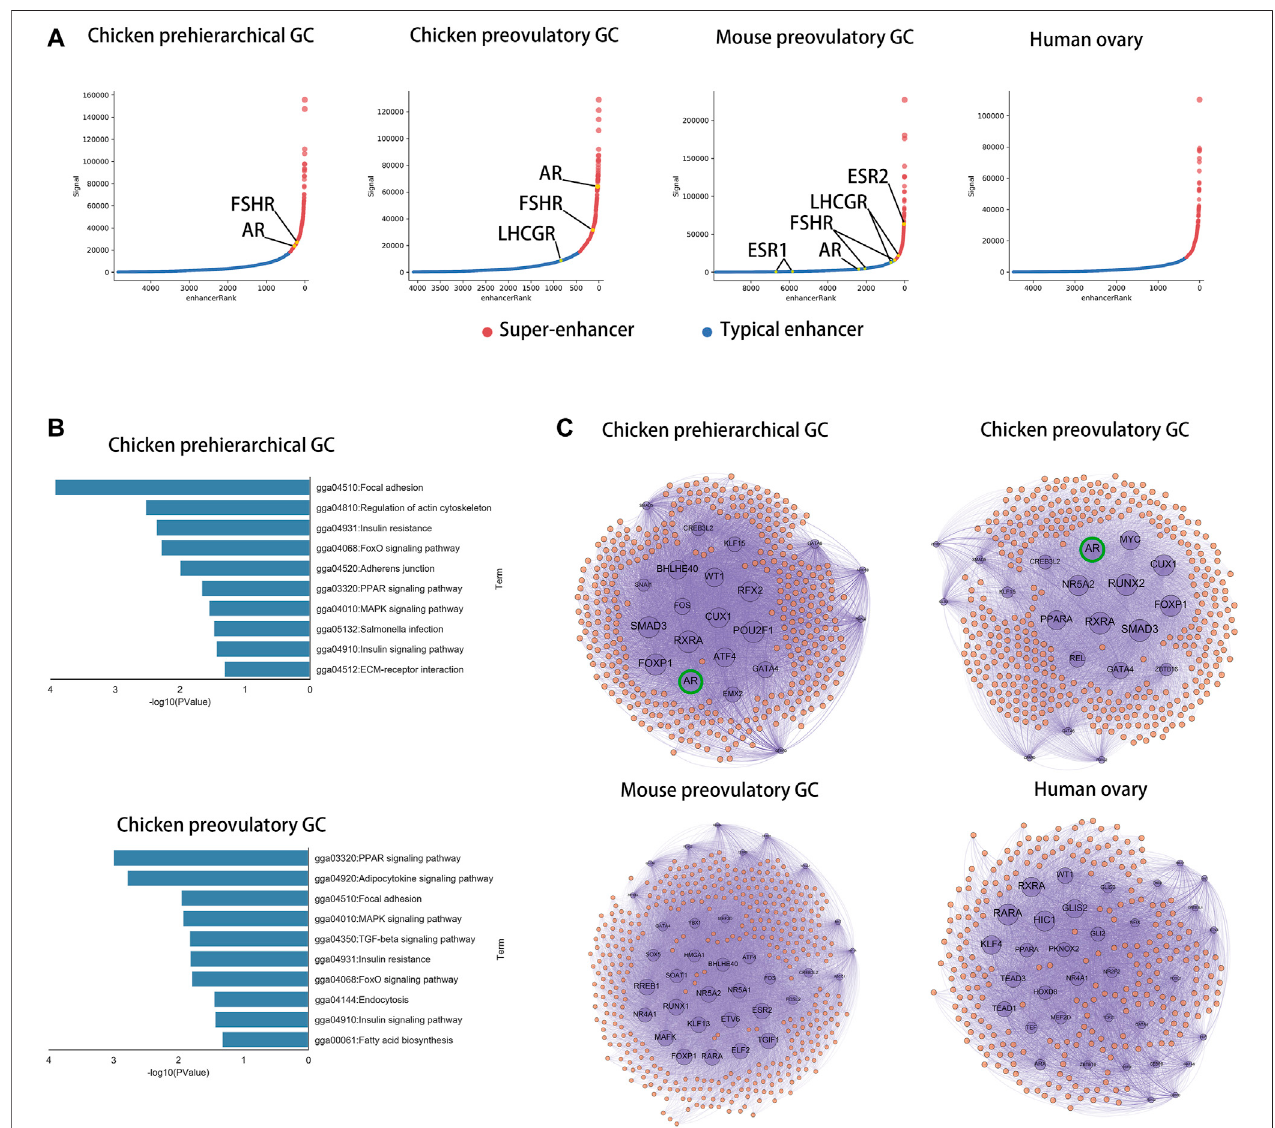
FIGURE4| ARisacoretranscriptionalregulatorspeci fi ctochickensin GCs. (A) Super-enhancers (red) and typical enhancers (blue) identi fi ed byROSE inchicken phGCs, chicken poGCs, mouse poGCs and human ovaries. Enhancer-associated hormone receptor gene names are tagged (orange). (B) Top ten KEGG pathways of SEGs in chicken phGCs and chicken poGCs. (C) The core transcriptional regulatory networks of chicken phGCs, chicken poGCs, mouse poGCs and human ovaries. Gene names of Hub-TFs (purple) are tagged.